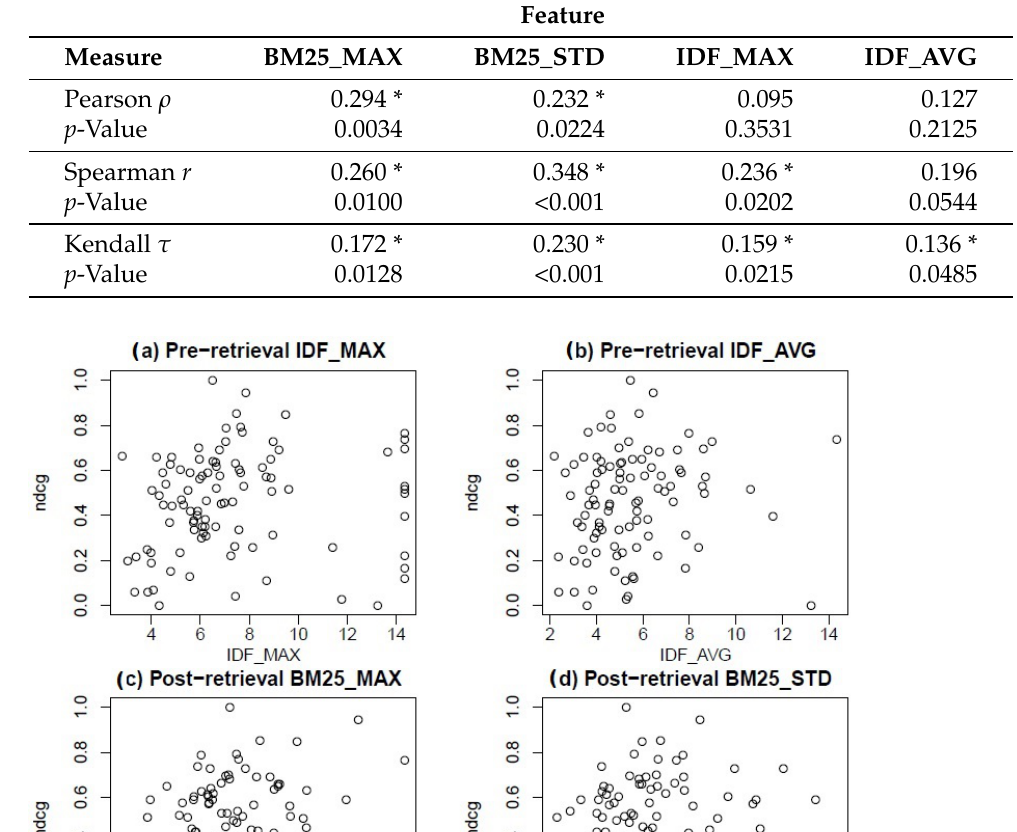
Table 1. Correlation between query features and ndcg. WT10G TREC collection. * marks the usual <0.05 p -Value significance.